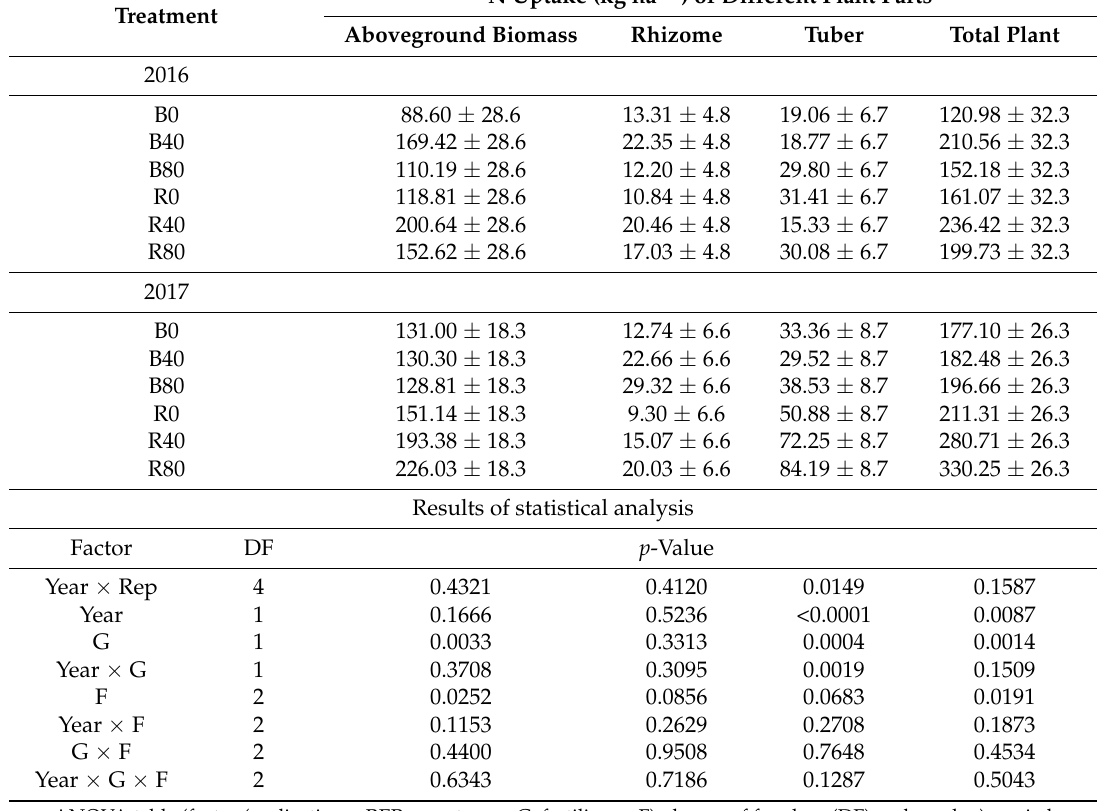
ANOVA table (factor (replication = REP; genotype = G; fertilizer = F), degree of freedom (DF) and p -value) carried out for nitrogen uptake in different plant parts and total